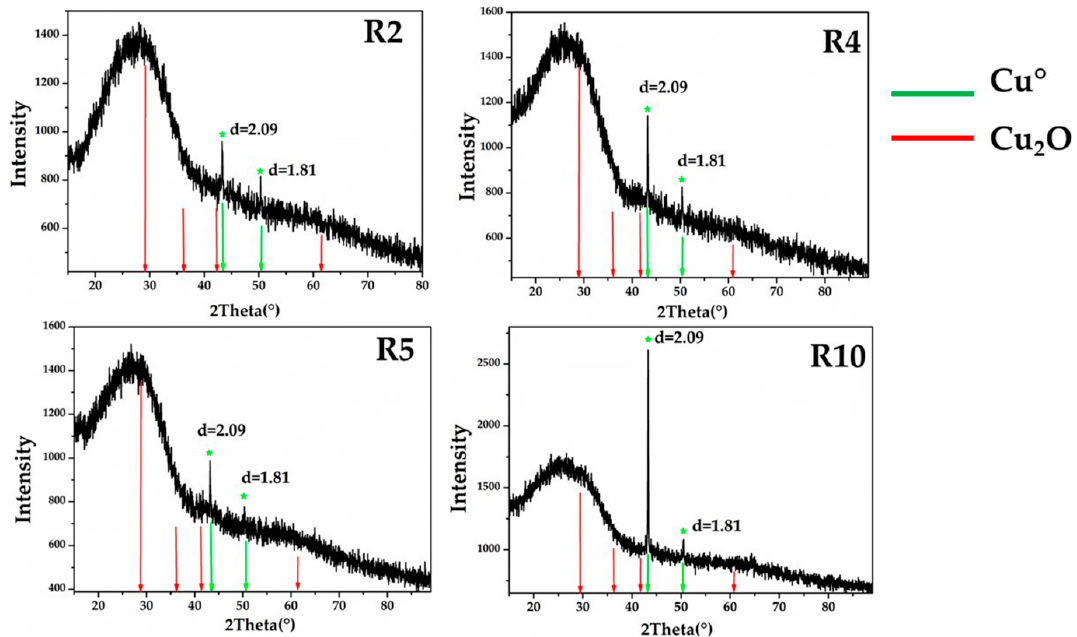
Figure 21. X-ray di ff raction on the samples of Gr-1 (R2-R4-R5) and Gr-2 (R10), showing the typical peaks of metallic copper. No cuprite crystals were detected.